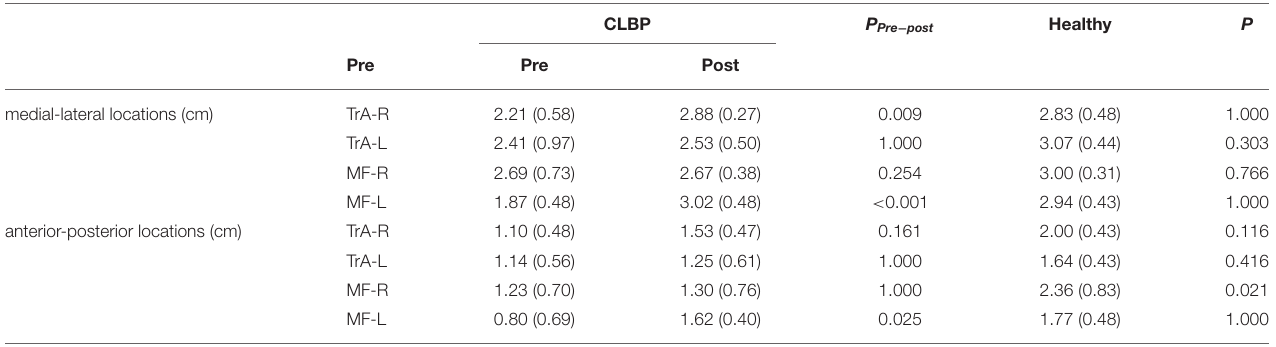
TABLE 3 | The CoG of the medial-lateral (x-CoG) and anterior-posterior coordinates (y-CoG) in the left and right hemispheres of the healthy and CLBP groups (mean ± SD). CLBP P Pre − post Healthy Pre Pre Post